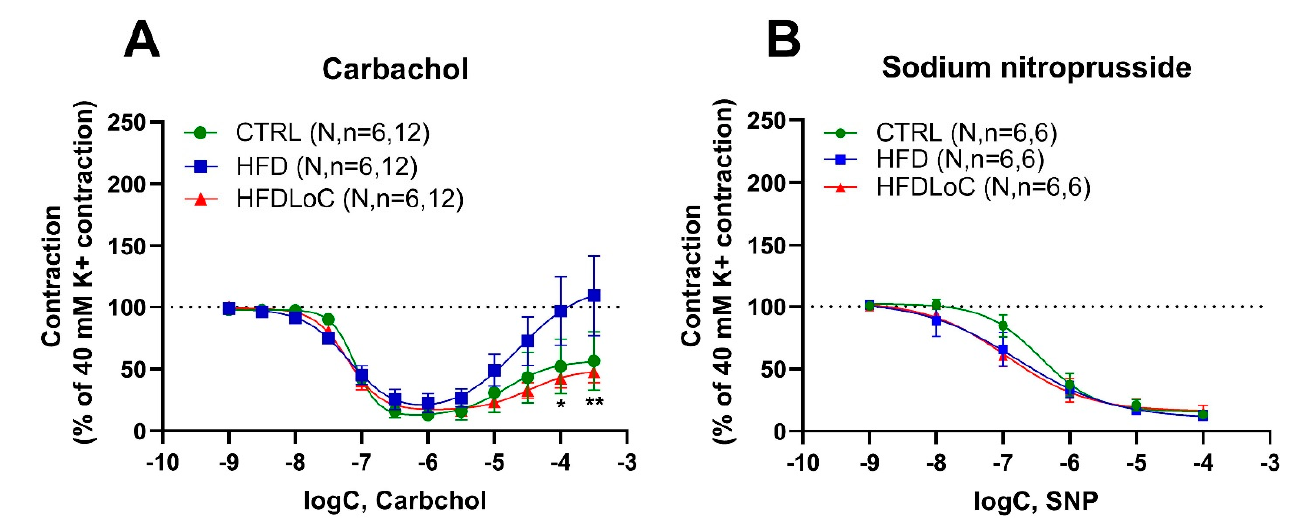
Figure 2. Wire myography studies in coronary arteries precontracted with 40 mM potassium and stimulated with ( A ) the muscarinic receptor agonist (carbachol) or ( B ) the nitric oxide donor (sodium nitroprusside) to induce endothelium-independent relaxation. ( A ) Carbachol induced similar relaxation in coronary arteries of the control (CTRL), HFD, and HFDLoC groups, whereas arteries from the HFD group contracted significantly higher concentrations of carbachol compared with the HFDLoC group. ( B ) Sodium-nitroprusside-induced relaxation was not different between the coronary arteries of the three diet groups. Mean ± SEM, * p < 0.05, ** p < 0.01 HFDLoC vs. HFD determined by 2-way ANOVA and Tukey’s multiple-comparisons test. N, number of animals; n , number of investigated